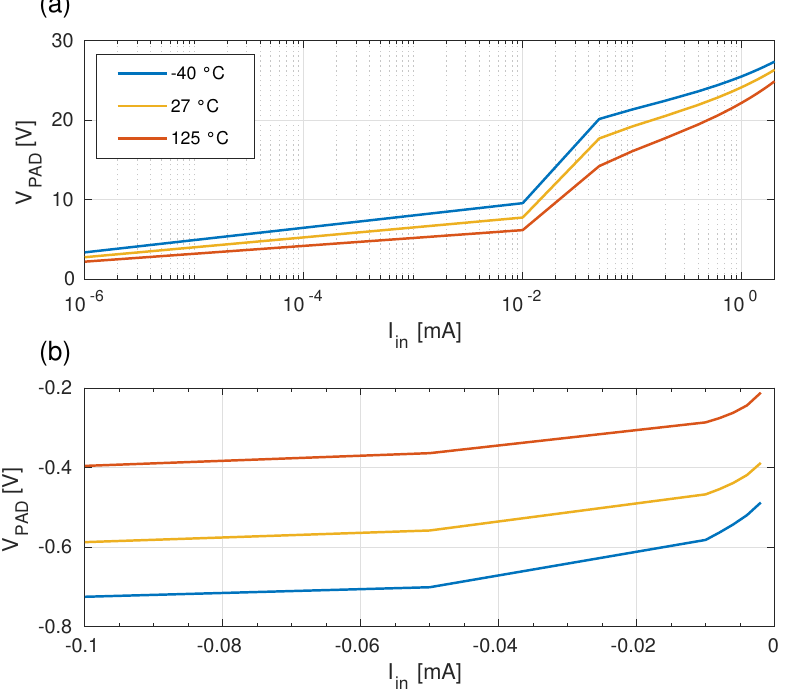
Figure 13. Voltage at the input of the interface circuit with multi-level voltage clamps in Figure 4 vs. input current, at − 40 ◦ C, 27 ◦ C, and 125 ◦ C chip temperature. ( a ) Positive input current sweep; ( b ) Negative input current